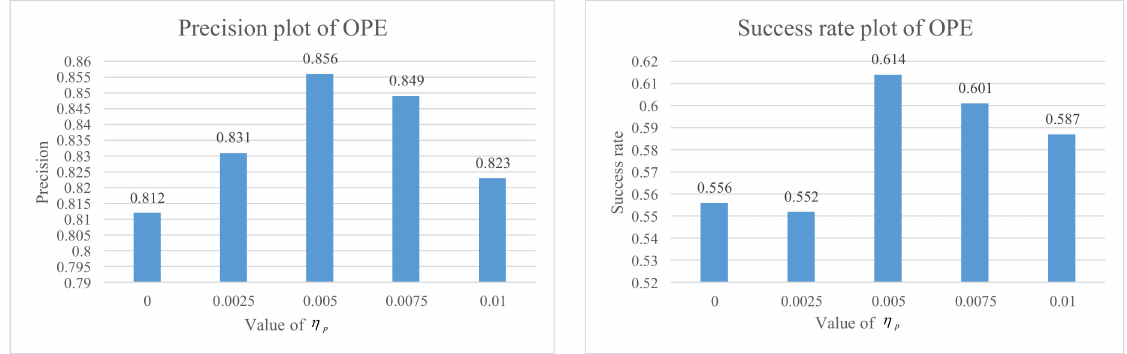
Figure 5. The experimental results for different reliability ratio threshold η P on